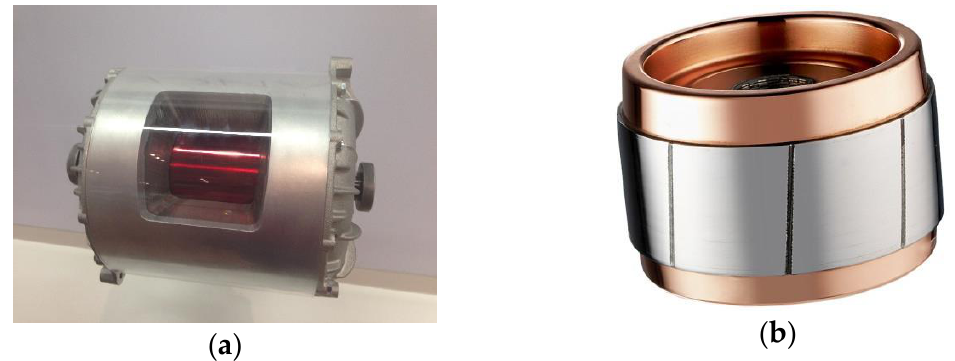
Figure 2. An example torque speed curve of the induction machine operating with a drive. Figure 3. Induction machine components, showing: ( a ) Tesla motor cut-out [36], and ( b ) die-cast copper rotor [37].